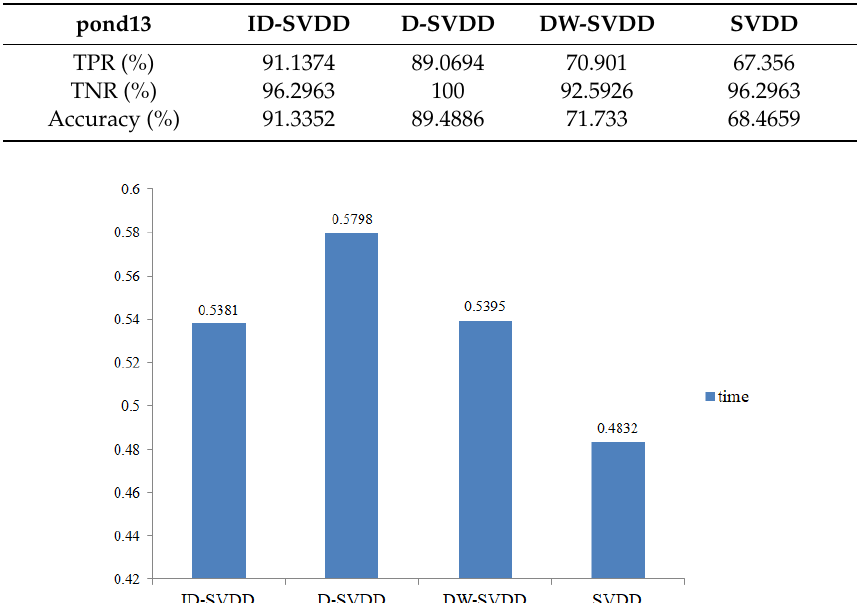
Table 5. Detection results for the water quality dataset. D-SVDD: density-compensated SVDD;